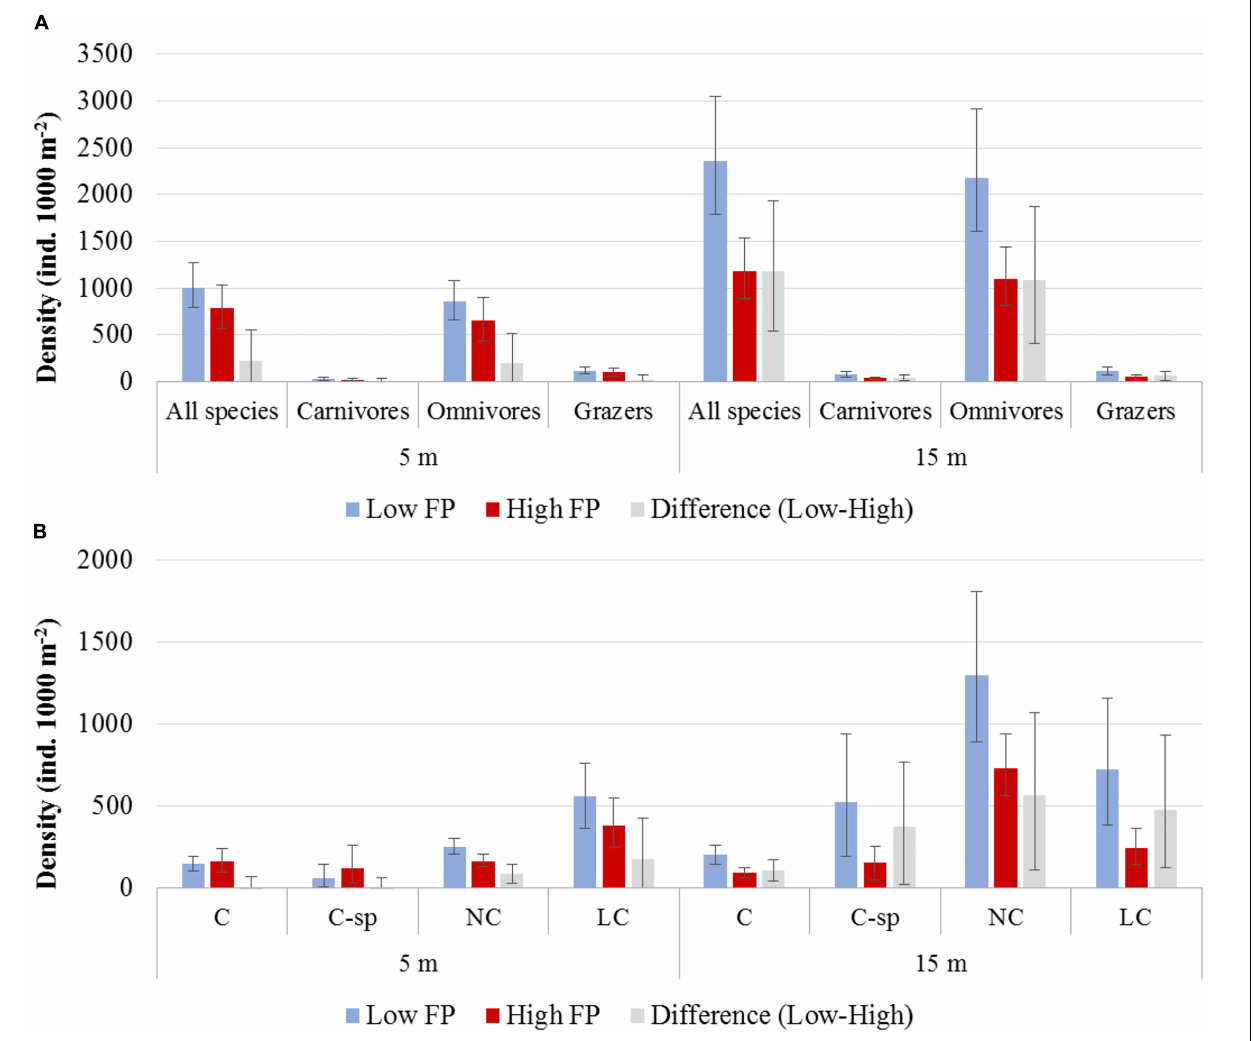
FIGURE 3 | Mean density and the 95% confidence interval (A) of total fish and trophic groups, and (B) of commercial status groups, for low and high fishing pressure (FP) sites, as well as for their difference (Low – High), at the 5 and 15 m depth zones. C, commercial, C-sp, commercial small pelagic, LC, non-commercial or sold in some areas but at low value, NC,